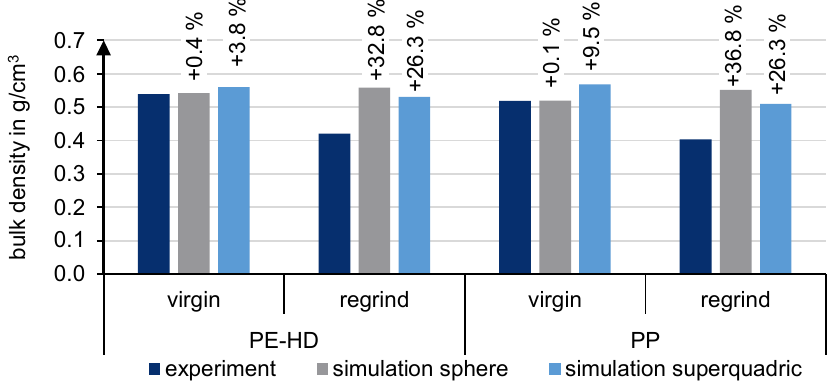
Figure 20. Bulk density comparison between experiment and simulation.